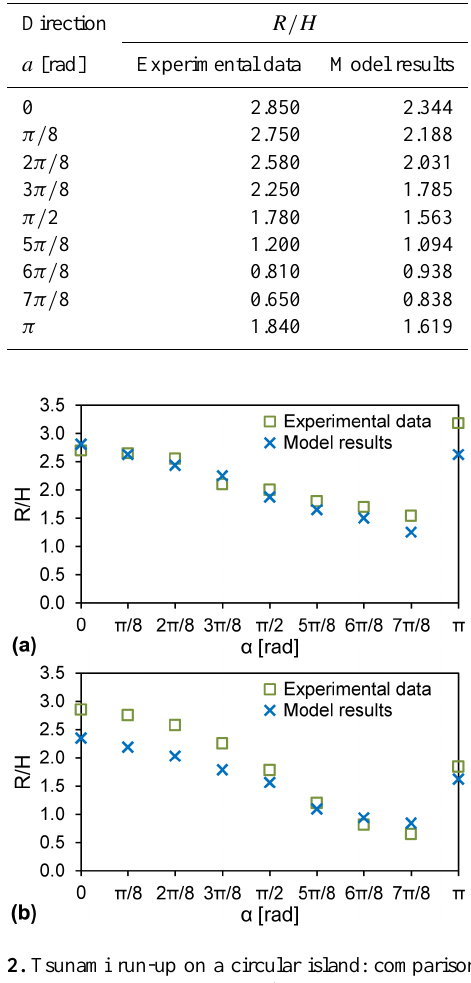
Table 2. Tsunami run-up on a circular island: comparison of the normalized maximum run-up height ( R/H) distribution around the island between model results and the measurements of Briggs et al. (1995) for ε = 0 . 20; the angle α = 0 corresponds to the front direction of the wave approaching the island and α = π to the back direction.